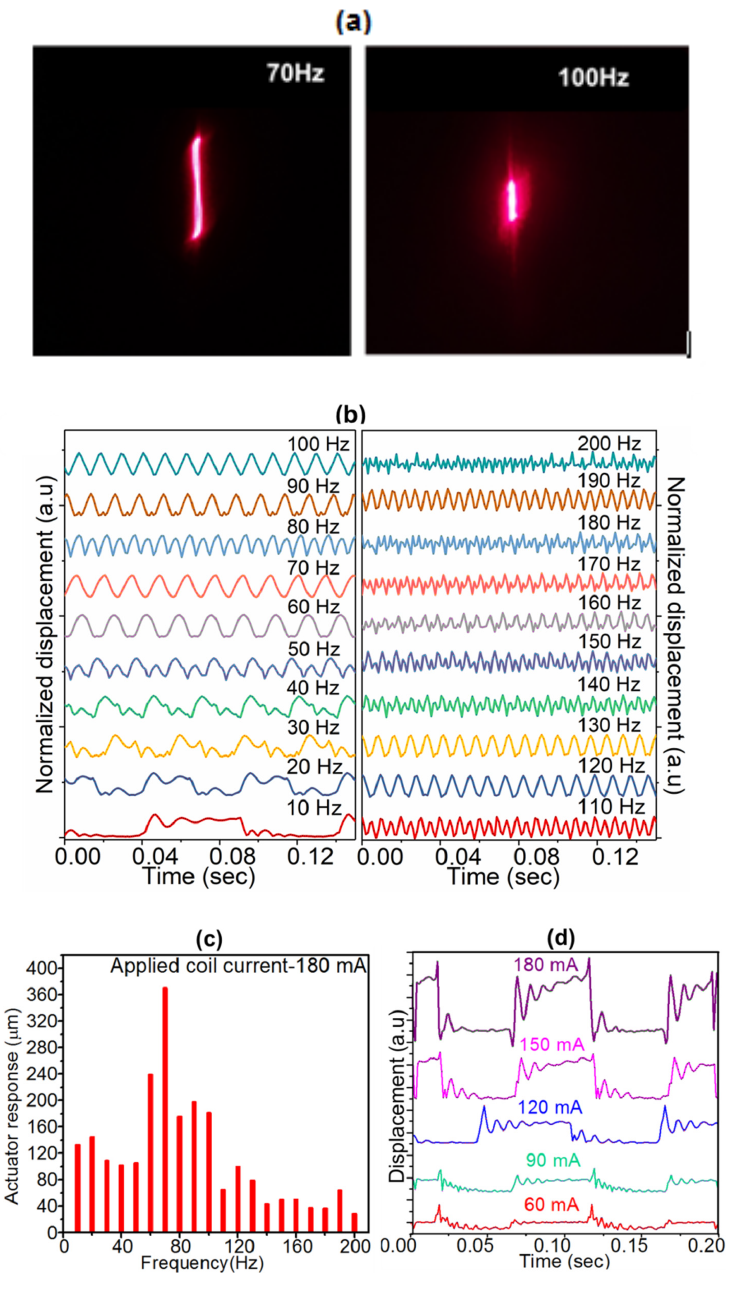
Figure 6. ( a ) Recorded amplitude of the actuator oscillation at 70Hz and 100Hz ( b ) Normalized transient displacement response of the actuator and ( c ) Peak actuator displacement as a function of applied frequency at a current of 180 mA ( d ) Transient response of the actuator at different currents and input frequency of 10 Hz.